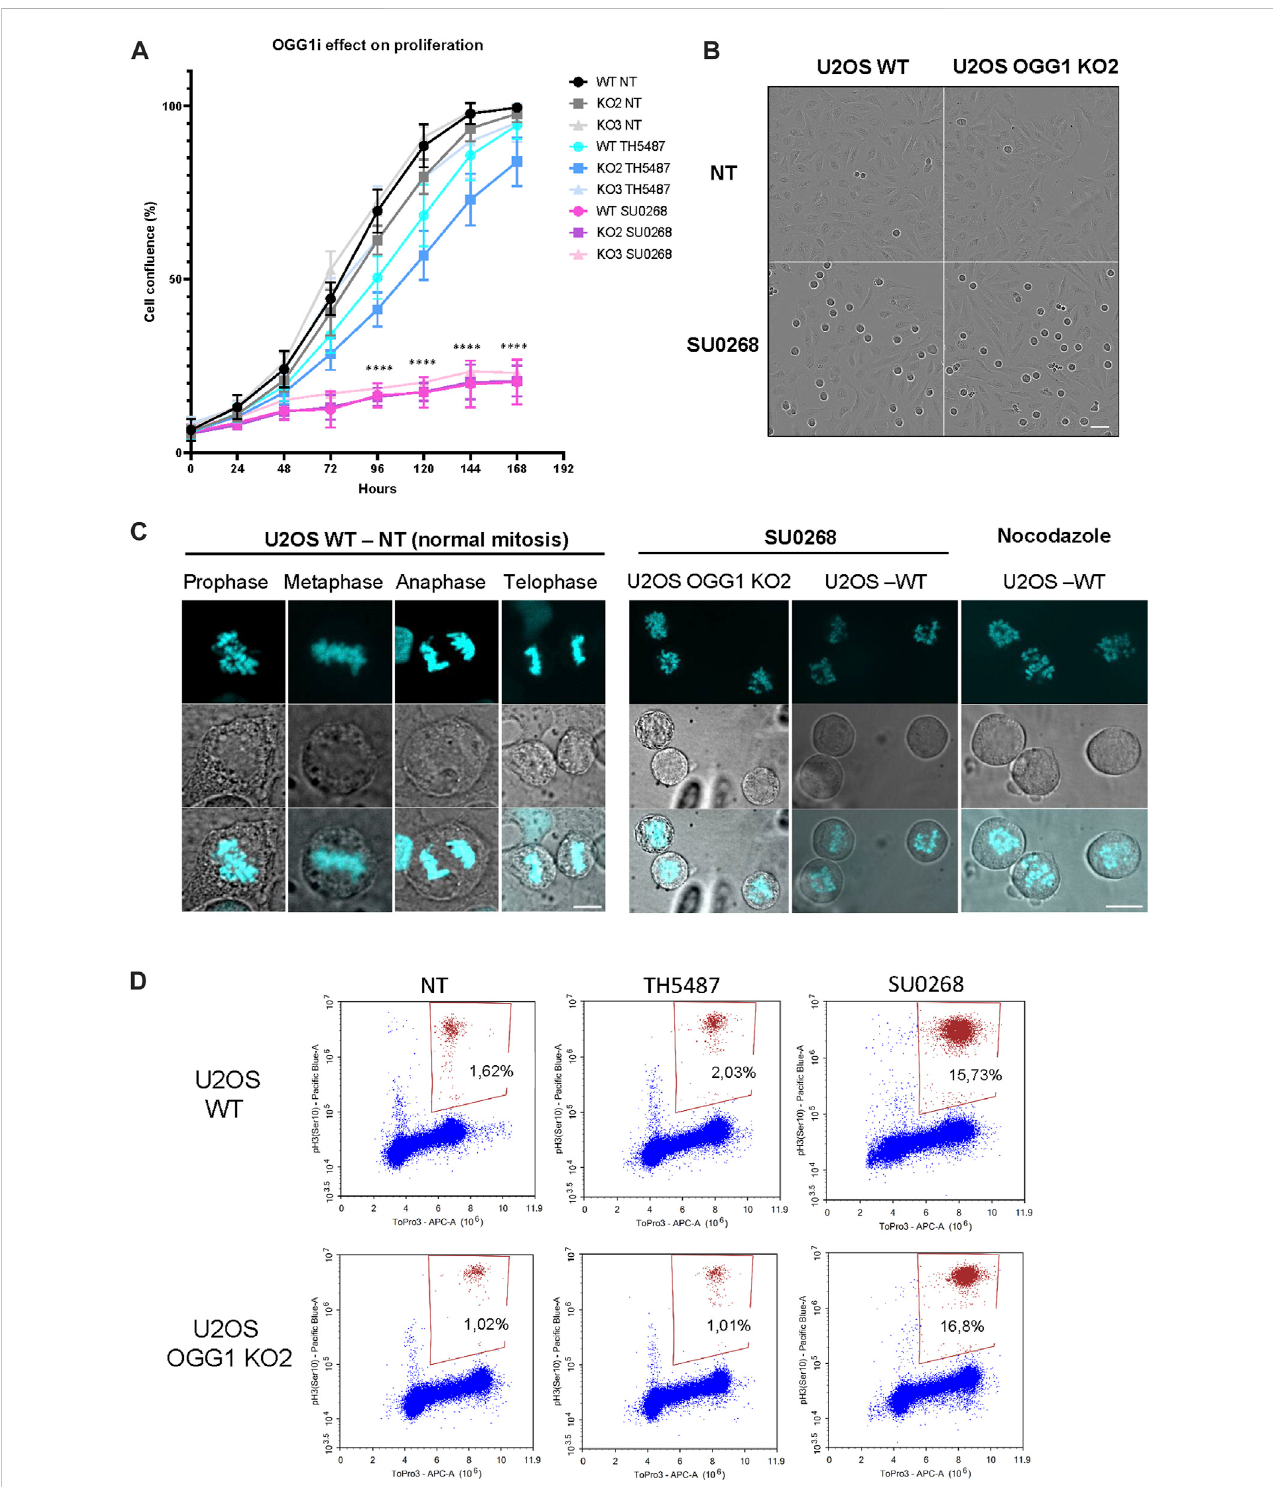
OGG1 inhibitor SU0268 impairs mitotic progression in an OGG1 independent way. (A) The proliferation of U2OS WT and OGG1 KO cells under chronic treatment with TH5487 and SU0268 (10 µM) was followed with Incucyte for one 1 week as described in materials and methods. Data are presented as mean con fl uence ±s.d. of at least three technical replicates from three independent experiments (left side). Mixed-effect analysis was performed (****) p < 0.0001. (B) Representative Incucyte transmission images of U2OS WT and OGG1 KO2 cells at basal conditions or treated with SU026. Scale bar 50 µm (C) Cells were exposedtoNocodazoleorSU0268for6 h,DNAwasstainedwithHo33342andcellswereimagedby fl uorescencemicroscopy.Fortheuntreatedcells,thedifferent phasesof mitosis(Prophase, Metaphase,Anaphaseand Telophase)areillustrated. OnlycellsinProphasewere observeduponexposureto SU0268or Nocodazole. Scale bars 10 µm. (D) Cellsundergoing mitosis were quanti fi ed by fl ow cytometry using an antibody againstPhospho-H3.A higheraccumulation of cellsinmitosis was observed for both U2OS WT and OGG1 KO2 in cells exposed to SU0268 compared to untreated cells or cells exposed to